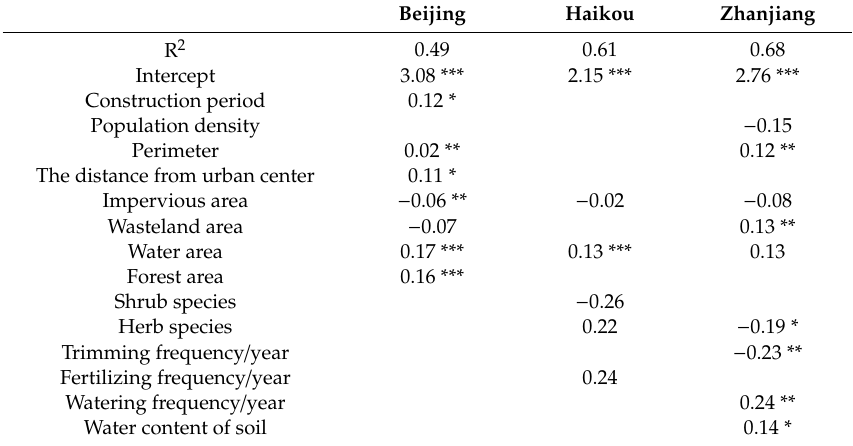
Table 3. The top models for predicting greening percentage in Beijing, Haikou, and Zhanjiang, China. The R-squared value (R 2 ) for each model and the estimated coe ffi cient for each predictor are